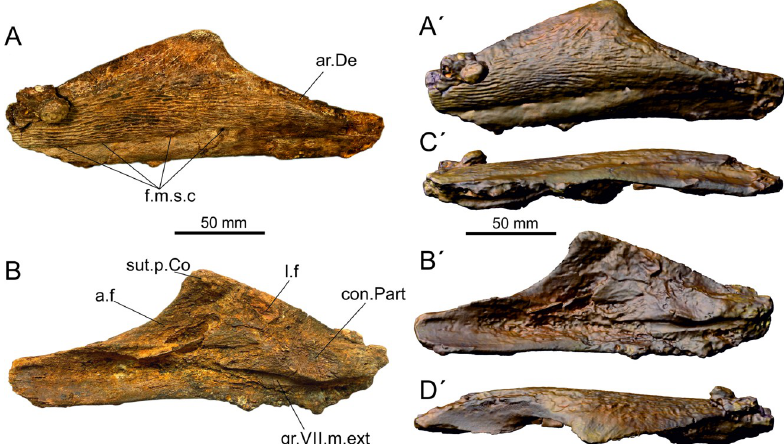
Fig 2. Photograph and surface rendering (apostrophes) of left angular (SMU 77688) of Mawsonia sp. from the Woodbine Formation in lateral (A), medial (B), ventral (C) and dorsal (D) views. Abbreviations: a.f, adductor fossa; ar. De: articular surface for dentary; con.Part, contact surface with prearticular; f.m.s.c, openings of the mandibular sensory canal; gr.VII.m.ext groove for external mandibular ramus of VII; l.f, longitudinal fossa; sut.p.Co, sutural contact surface with principal